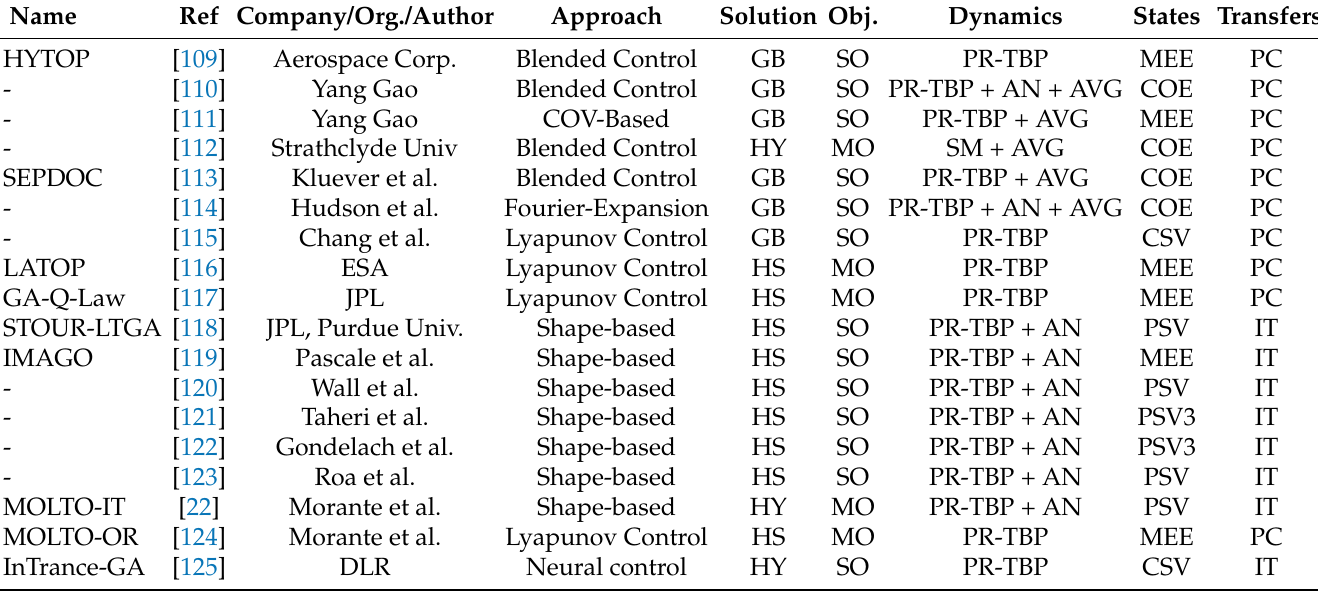
presented a first-order analytical solution for general transfers. He exploits the benefits of using a set of nonsingular orbital elements. Representative Tools Implementing Direct Methods with Predefined Control laws for Low-Thrust Trajectory Optimization.